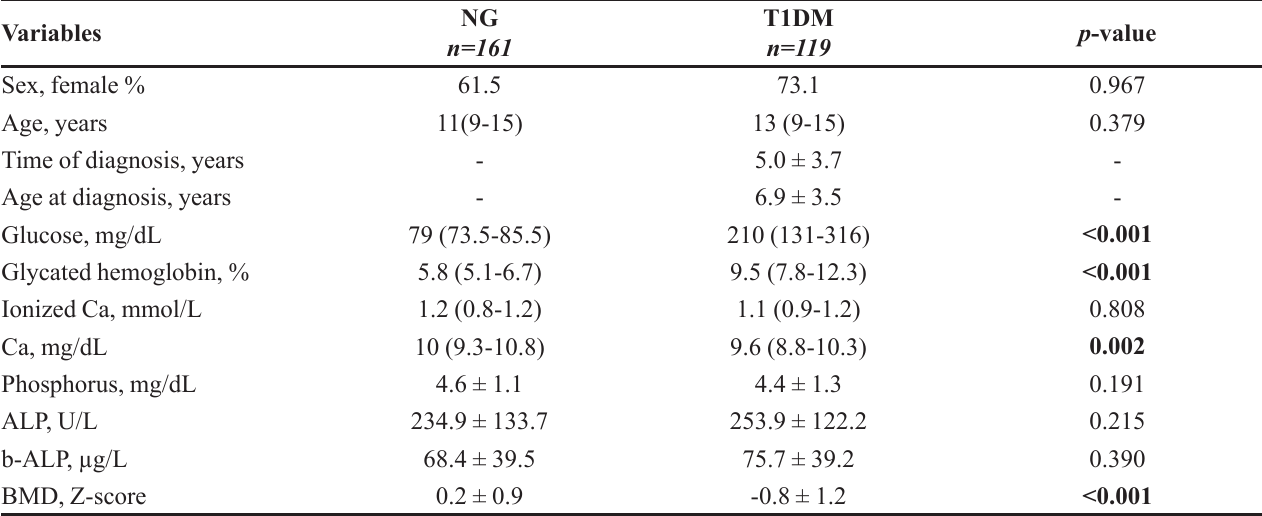
TABLE I - Biochemical and clinical data for NG and T1DM groups